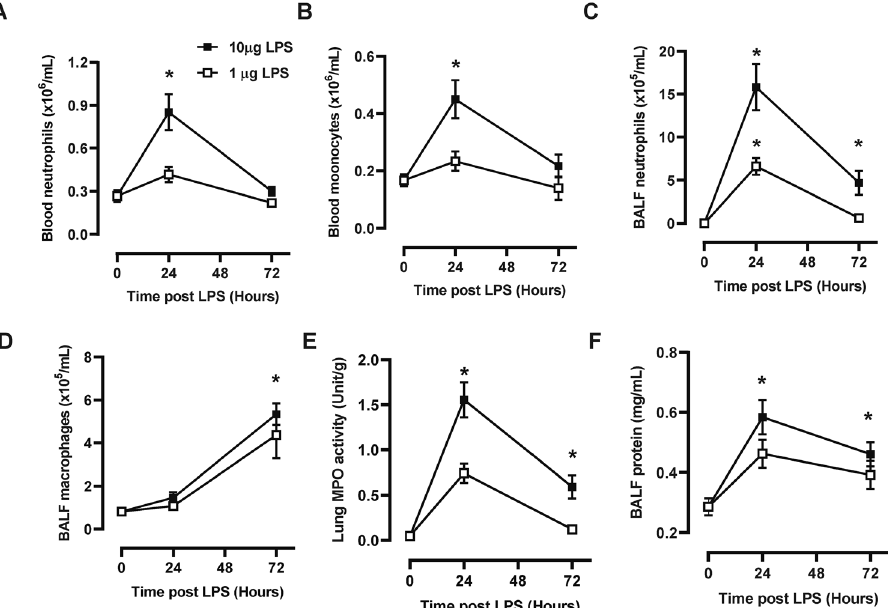
Fig. 1 LPS challenge initiates blood myeloid cell expansion and lung leukocyte traf fi cking. A Blood neutrophil and ( B ) monocyte numbers were quanti fi ed in h β c Tg mice treated with LPS (1 or 10 μ g). C BAL neutrophil and ( D ) macrophage numbers were also quanti fi ed after LPS challenge ( E ) MPO activity was quanti fi ed in lung tissue as a marker for tissue neutrophil in fi ltration. F Total protein levels in BAL- fl uid was also measured. n = 5 – 6; data are Mean ± SE; * p < 0.05, one-way ANOVA.